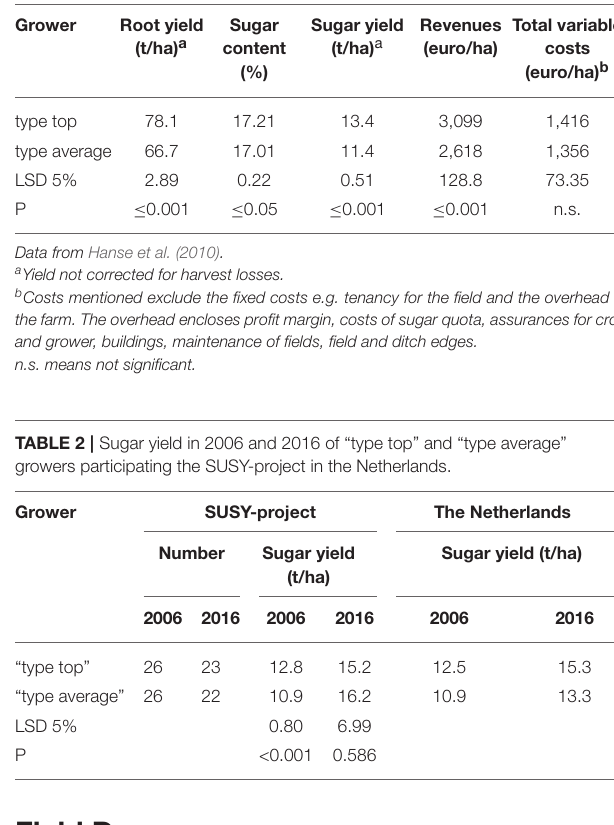
TABLE 3 | Fifteen tips for a high sugar yield from sugar beet growers participating the Best Practice